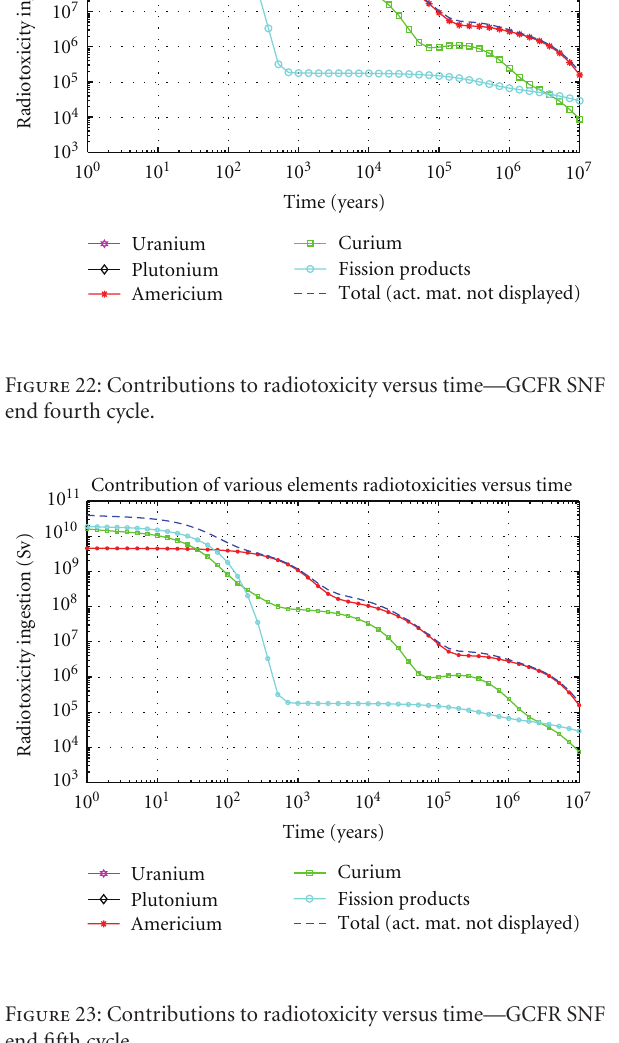
Figure 23: Contributions to radiotoxicity versus time—GCFR SNF end fifth cycle.